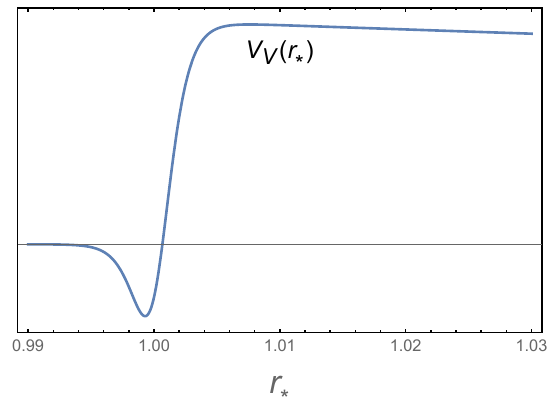
Figure 2. A schematic diagram representing the vector potential V V ( r (cid:3) ) in the near-horizon region for n = D (cid:0) 3 = 1000 and angular momentum l = 5, where r (cid:3) = R dr=f . The decoupled (light) modes of frequency ! (cid:24) O (1) in n live in the dip of the